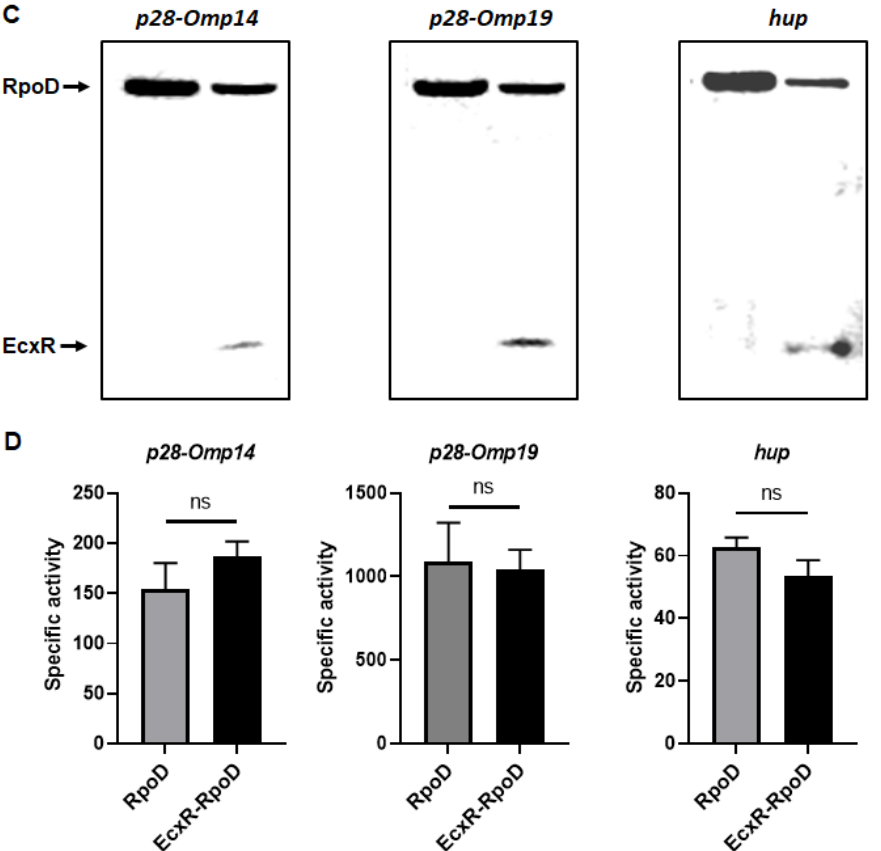
Figure 7. Assess the role of EcxR on the transcription of E. chaffeensis promoter-lacZ reporter con- structs. β -galactosidase assays were performed to measure the transcriptional activities of lacZ reporter constructs. ( A , C ) Western blot analyses of samples from β -galactosidase assays were carried out using an anti-His tag antibody to verify the expression of RpoH ( σ 32 ) or RpoD ( σ 70 ) alone or with EcxR expression. The positions of RpoH, RpoD and EcxR are indicated by arrowheads. ( B ) The β -galactosidase expression driven by E. chaffeensis promoters constructs encoding clpB, groES/L and dnaK were quantitated in the CAG57101 strain of E. coli expressing E. chaffeensis EcxR and σ 32 (EcxR-RpoH) or only E. chaffeensis σ 32 (RpoH), which were grown at 30 ◦ C. ( D ) The β -galactosidase expression driven by E. chaffeensis promoters constructs encoding p28-Omp14, p28-Omp19 and hup were quantitated in the CAG20177 strain of E. coli expressing E. chaffeensis EcxR and σ 70 (EcxR-RpoD) or only E. chaffeensis σ 70 (RpoD), which were grown at 37 ◦ C. The values are the means ± standard deviations for three independent biological replicates. Significant differences from the values for sam- ples lacking the expression of protein EcxR were determined by the t test (**, p < 0.01; ***, p < 0.001; ns, not